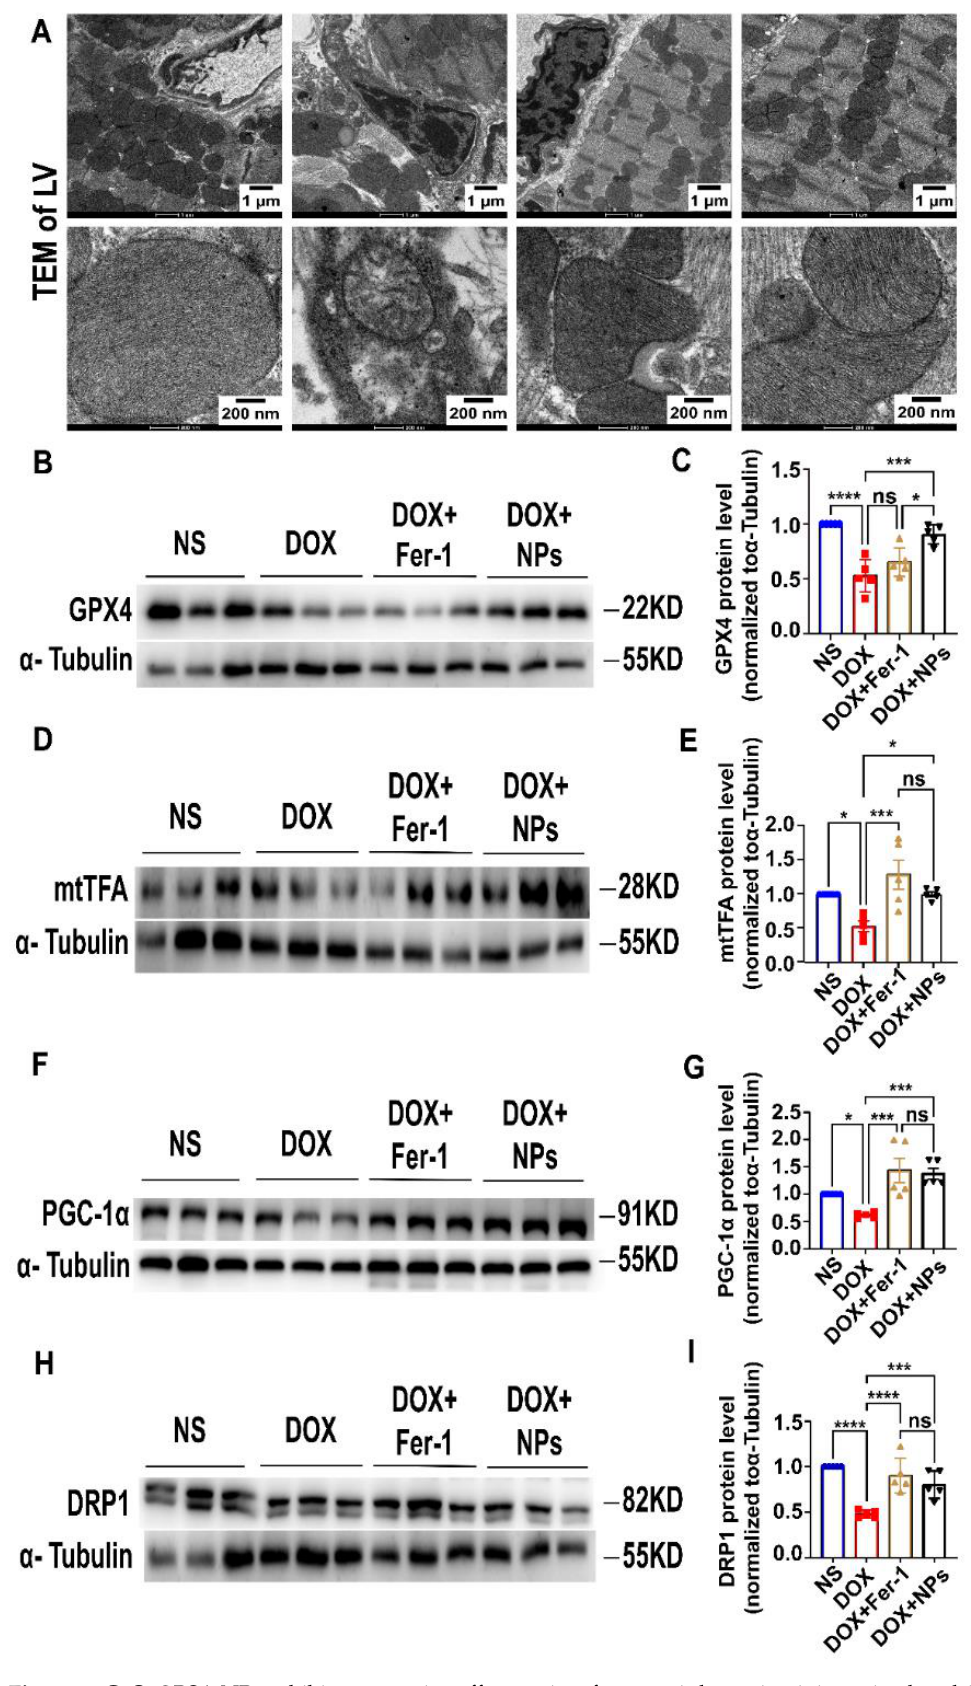
Figure 6. CeO 2 @BSA NPs exhibit a protective effect against ferroptosis by maintaining